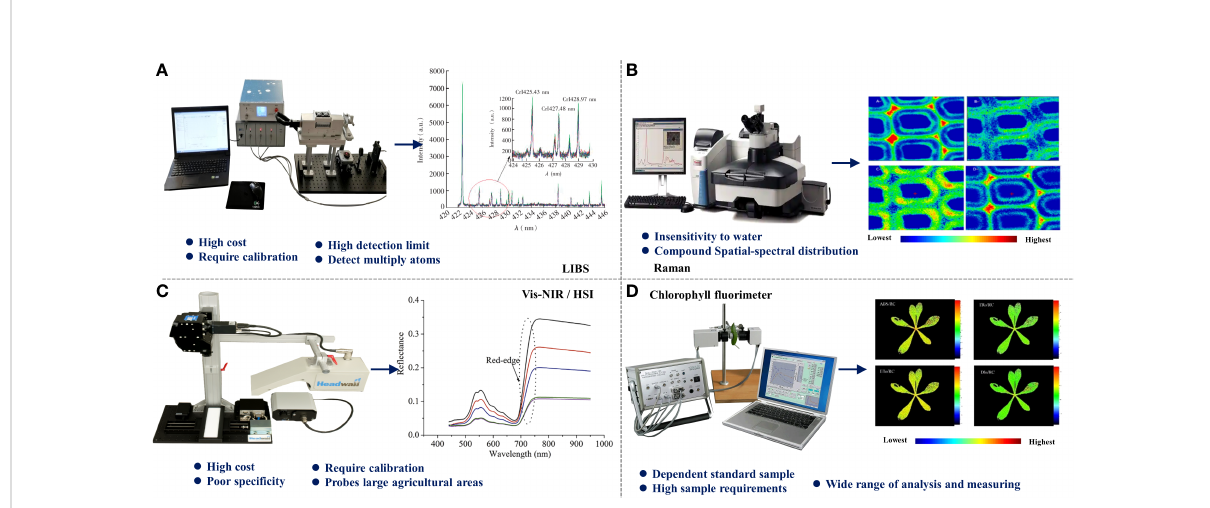
FIGURE 2 The principle and characteristics of spectral technology. (A) Laser induced breakdown spectroscopy (LIBS). (B) Raman spectrum. (C) Visible/ Near-infrared spectroscopy (Vis-NIR)/Hyperspectral imaging (HSI). (D) Chlorophyll fl